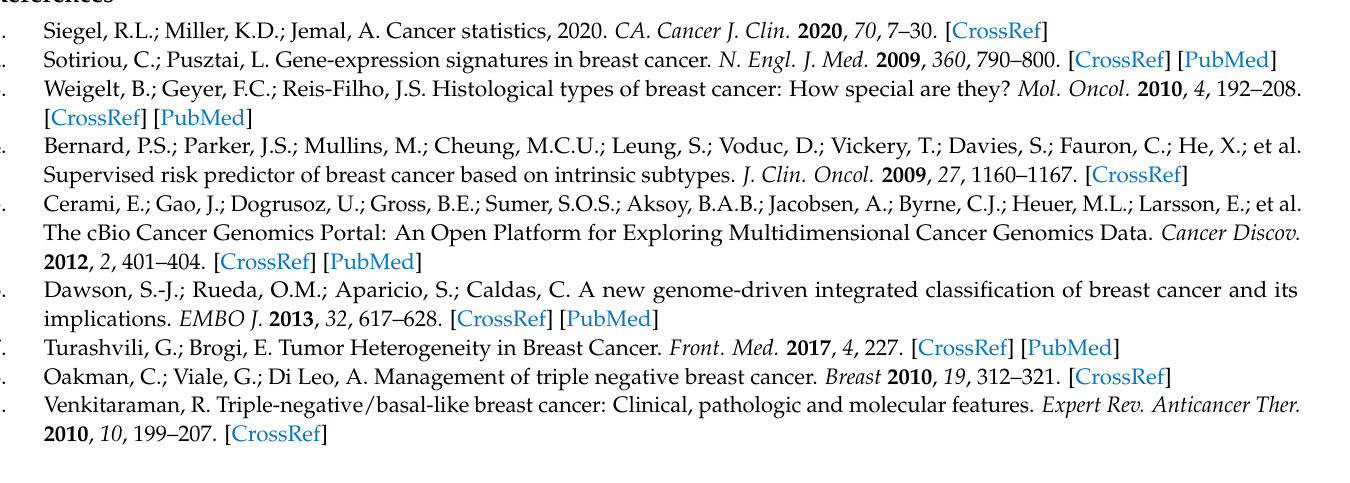
Figure S5: Evaluation of c-Rel protein expression in MDA-MB-231 and SUM159 cells; Figure S6: Efficiency of S100A4 immunodepletion in conditioned medium (CM) collected from MDA-MB-231 and SUM159